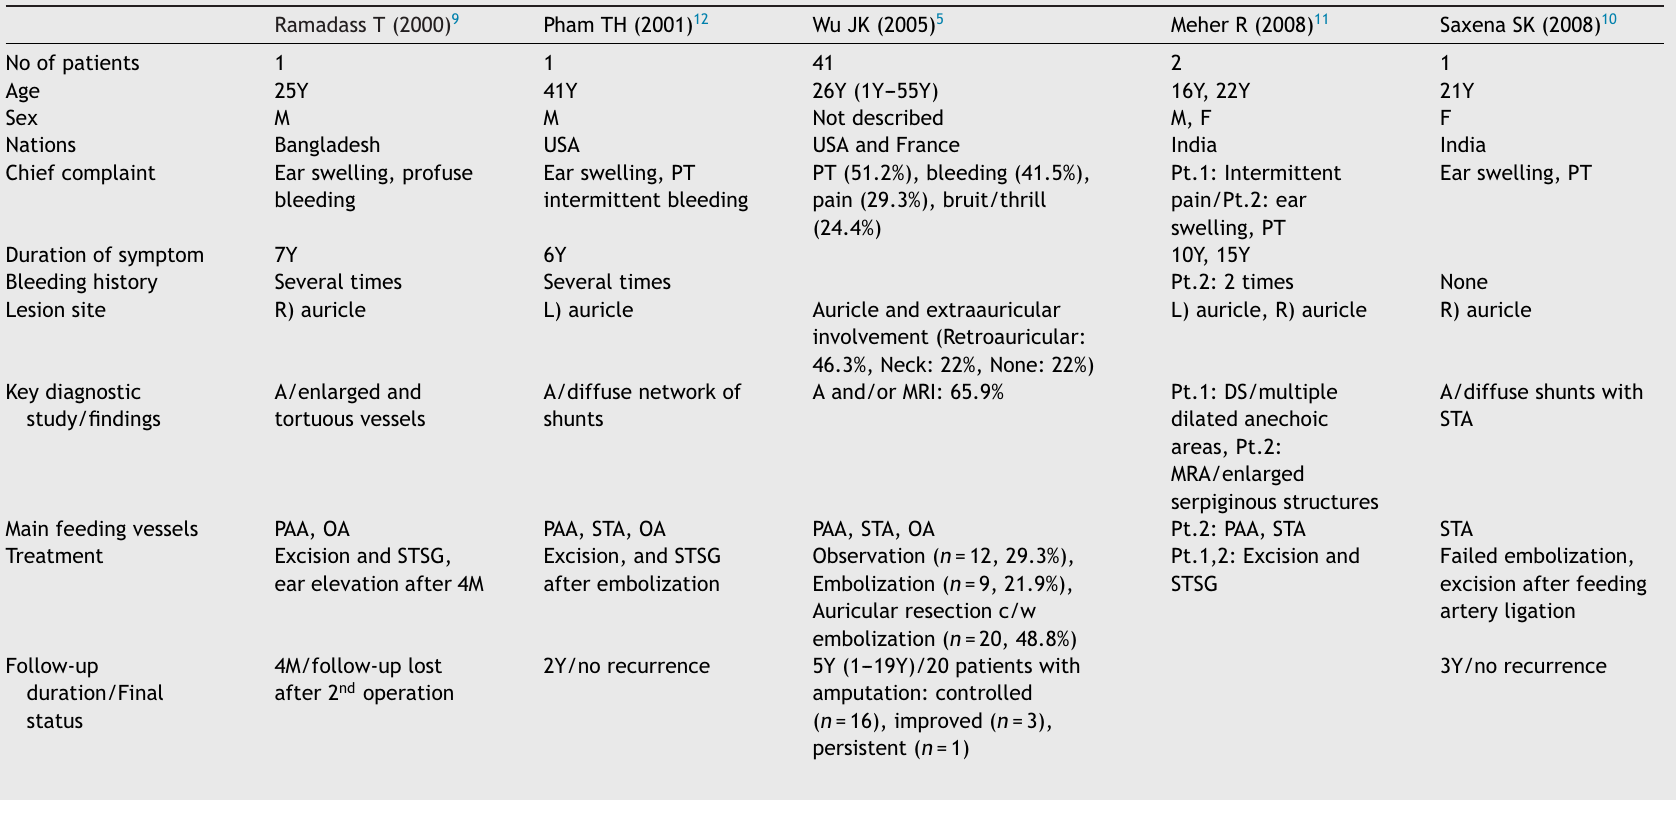
Summary of cases showing arteriovenous malformation of the external ear from previous reported literatures and this